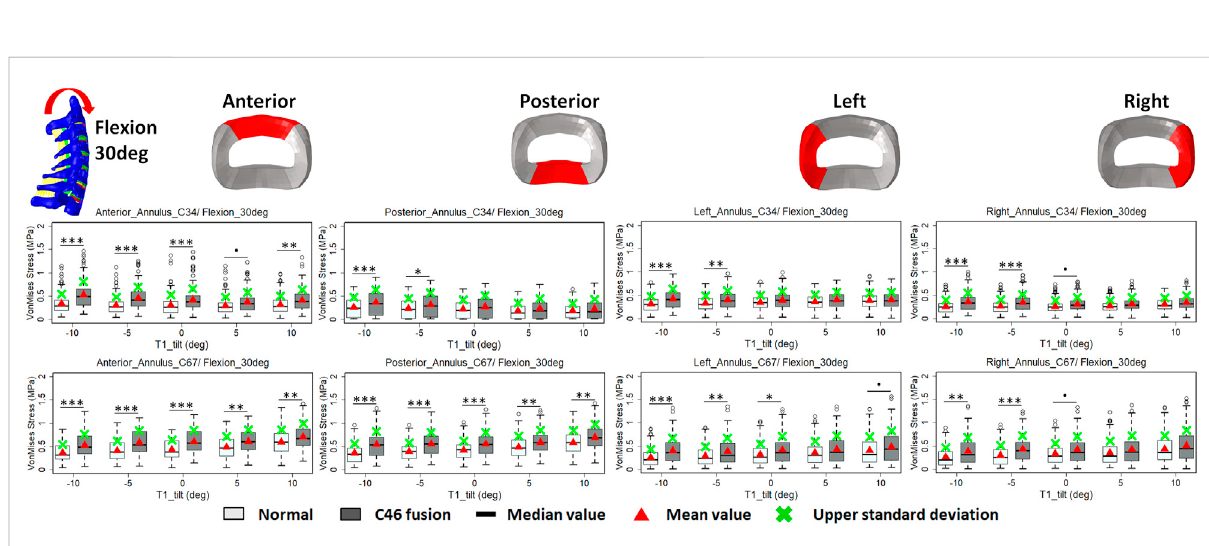
FIGURE 6 Comparison of average VonMises stress at different regions of annulus fi brosus at adjacent segments (C3 – 4 and C6 – 7) before and after C4 – 6 ACF with varying T1 tilt degrees under the 30 ° fl exion loading (Signi fi cance level of p value: ‘ *** ’ < 0.001; ‘ ** ’ < 0.01; ‘ * ’ < 0.05; ‘ . ’ < 0.1; ‘’ > 0.1).